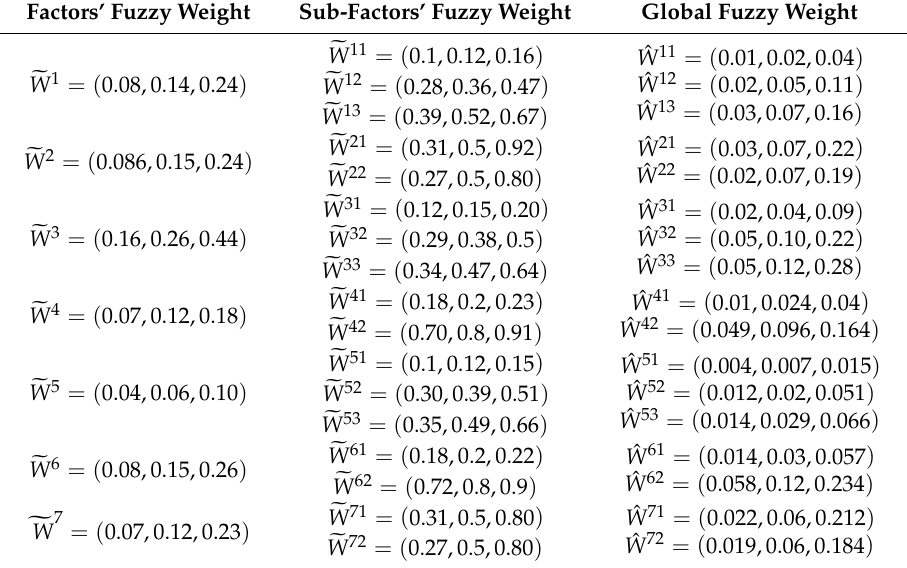
Table 6. Representing Global Fuzzy weights.